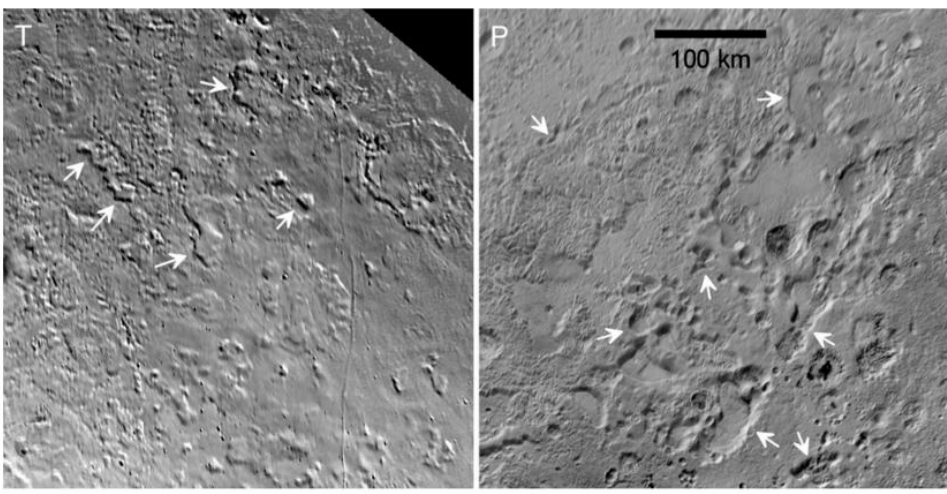
Figure 32. Eroded plains on (T) Triton and (P) Pluto. Images shown to same scale (0.35 km/pixel) and same dimensions; scene width is 375